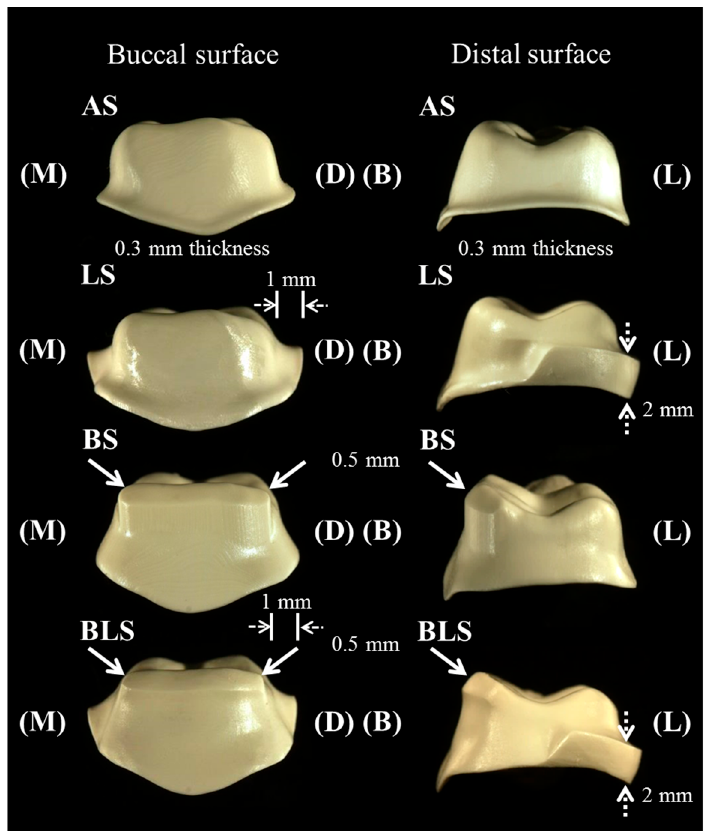
Figure 2. Ceria-stabilized tetragonal zirconia/alumina nanocomposite framework designs. White arrows and white dotted arrows show buccal and lingual supporting structures, respectively. Details of experimental groups are shown in Table 1. Abbreviations: B = buccal side; D = distal side; L = lingual side; and M = mesial side.